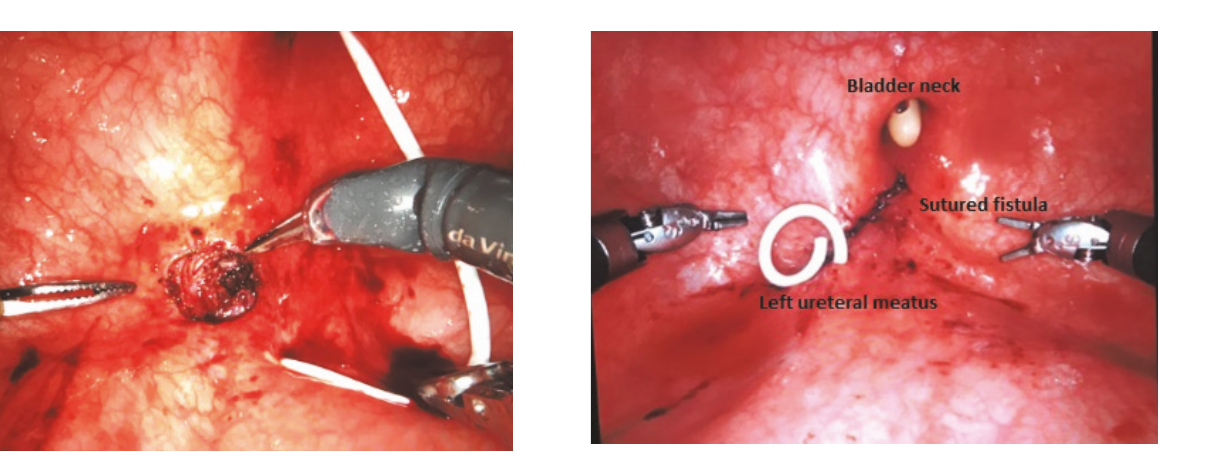
Figure 4: Fistula dissection is performed by separating vaginal and bladder sides.